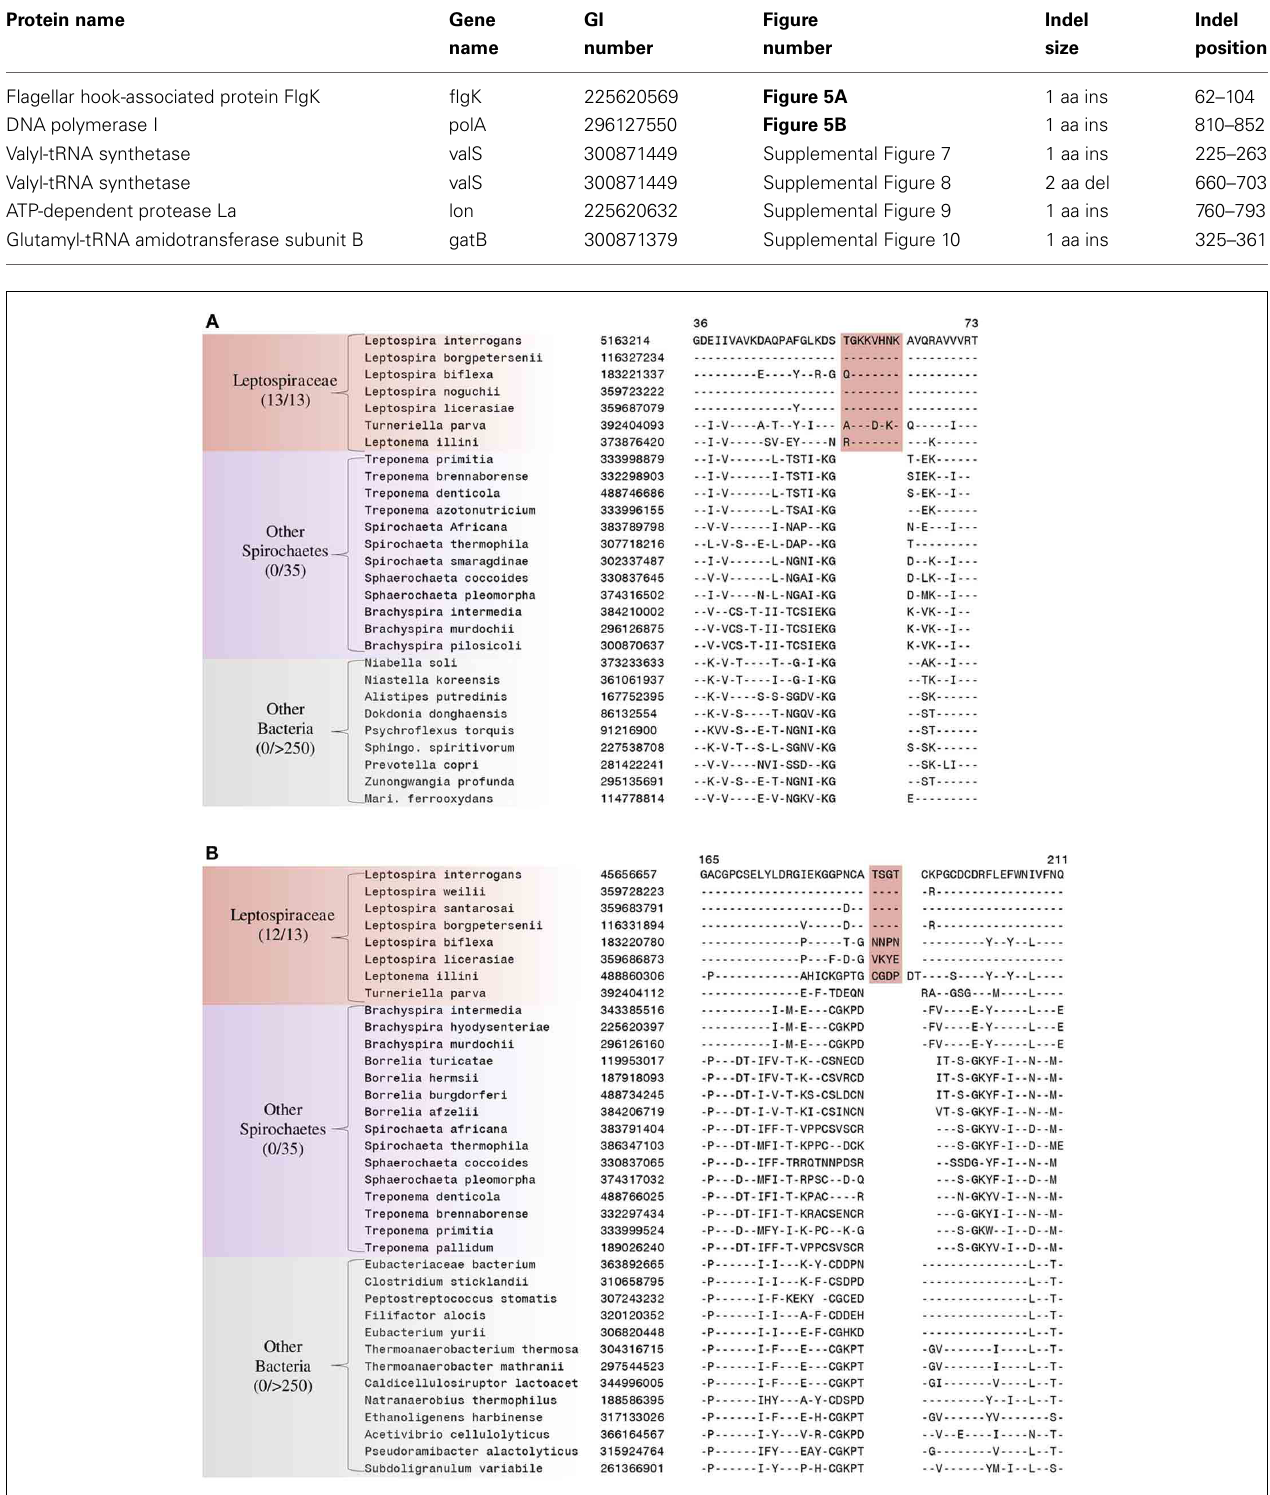
Table 3 | Conserved signature Indels that are specific for members of the family Brachyspiraceae.